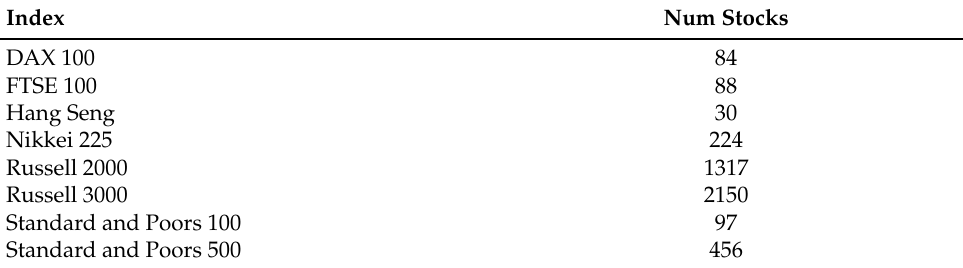
Table 1. Indices and Number of Constituents in